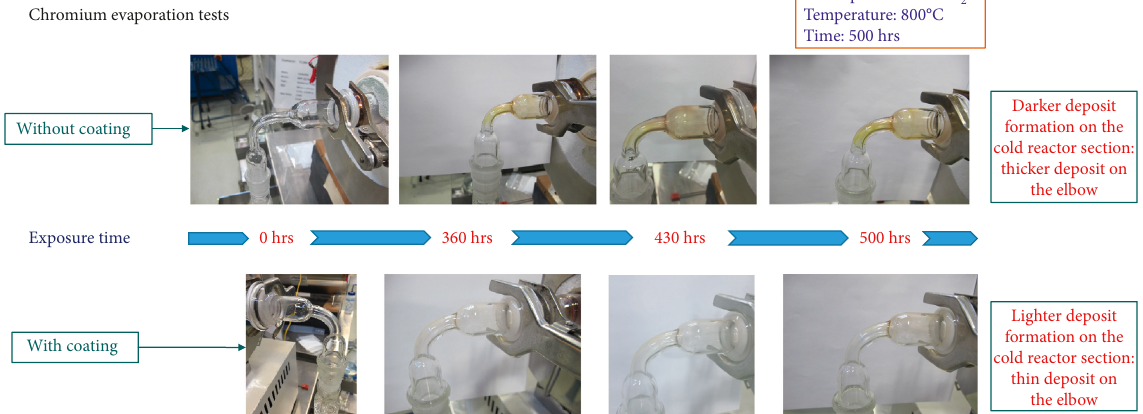
1-inch 0.020-inch samples showing condensate at × ×